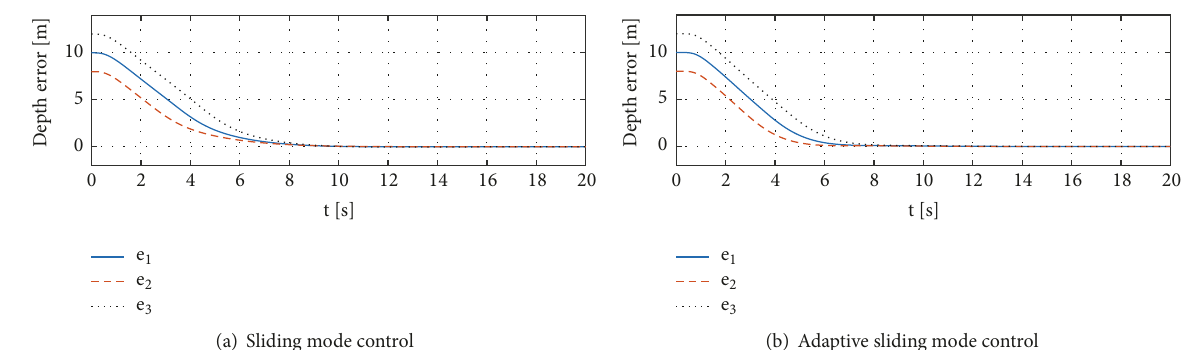
Figure 8: The coordinated errors of depth